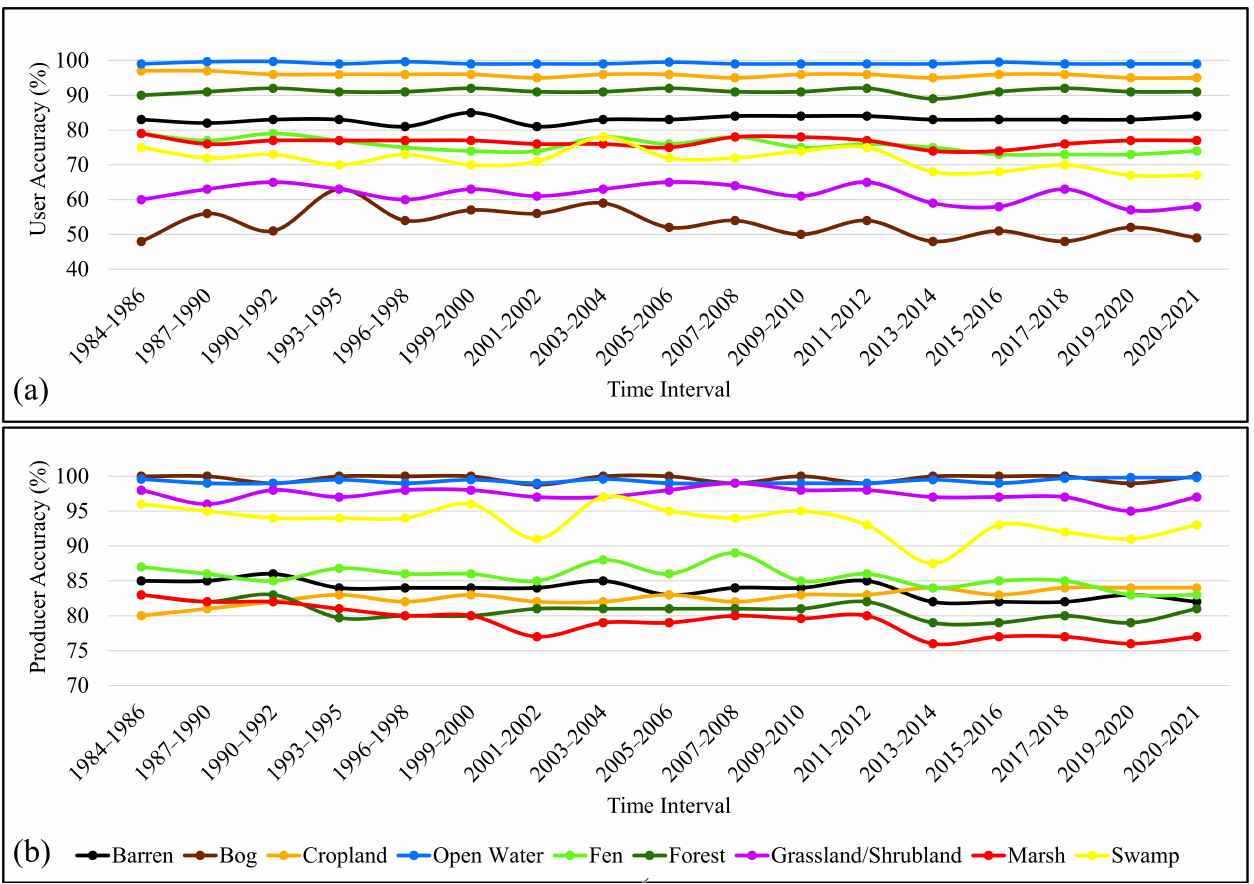
Figure 10. ( a ) User Accuracies (UAs) and ( b ) Producer Accuracies (PAs) of nine classes of the generated wetland maps for all time intervals between 1984 and 2021. Table 3. Confusion matrix of the generated wetland map of the Great Lakes basin using